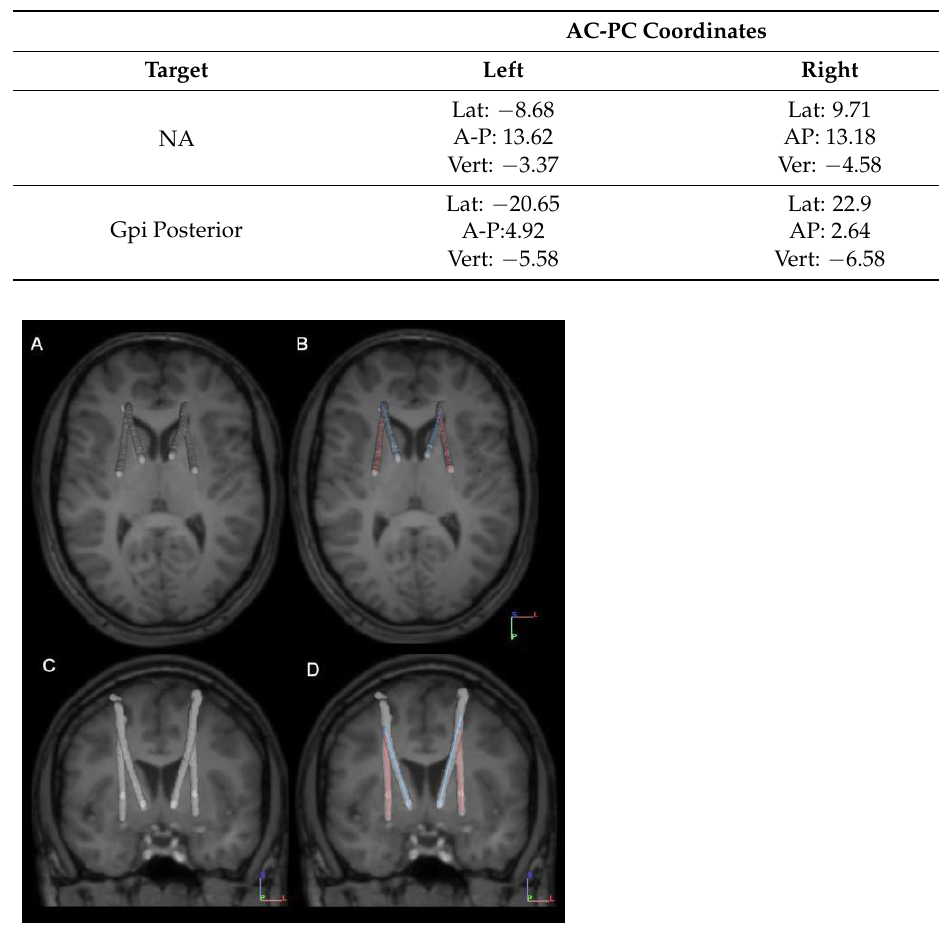
Table 2. Target coordinates relative to AC-PC midpoint of permanent Medtronic 3387 leads.